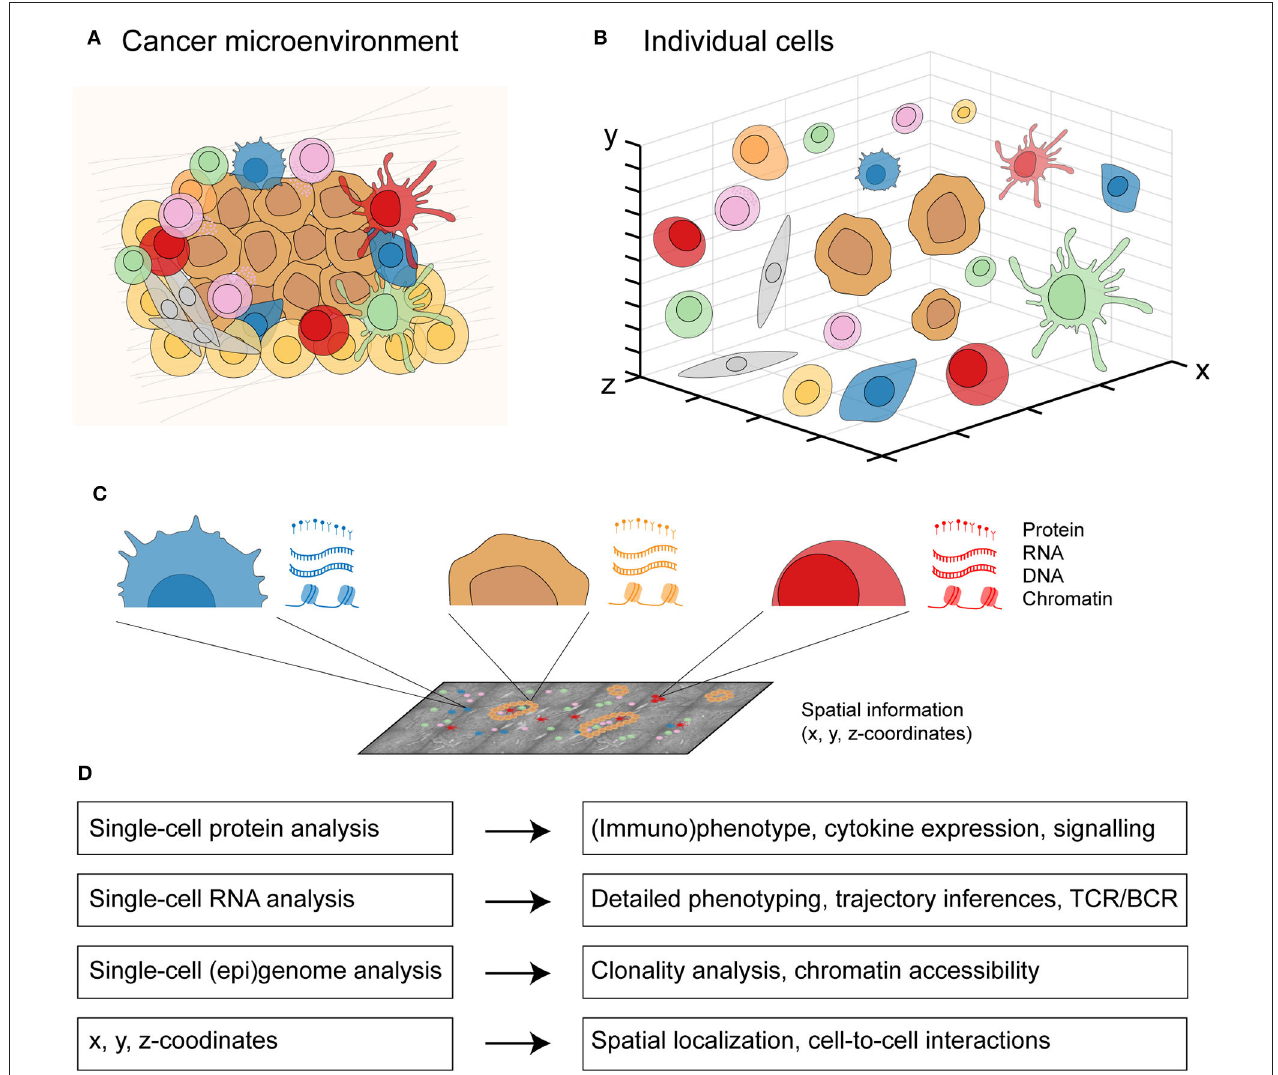
FIGURE 2 | An integrated multicellular model of cancer. (A) From cells in a spatially-organized cancer microenvironment to (B) a three-dimensional view of individual cells. (C) From each individual cell in the cancer microenvironment, protein expression can be measured by single-cell protein analysis, RNA expression by single-cell RNA analysis, DNA and chromatin expression by single-cell (epi)genome analysis, and the x, y, z-coordinates with spatially-resolved analysis. (D) Integrating all four molecular layers for each cell will allow a detailed profiling from individual cell-to-cell interactions to whole tissue